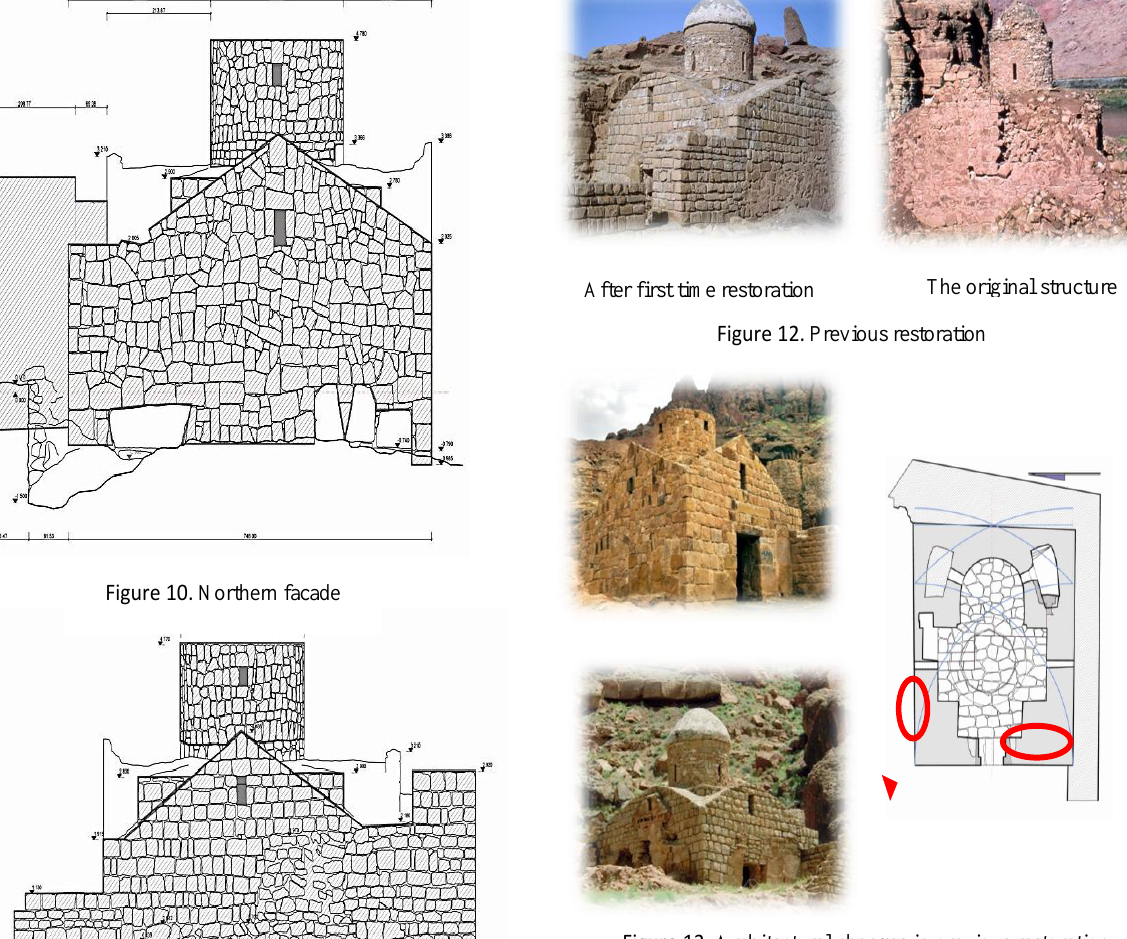
Figure 13. Architectural changes in previous restoration